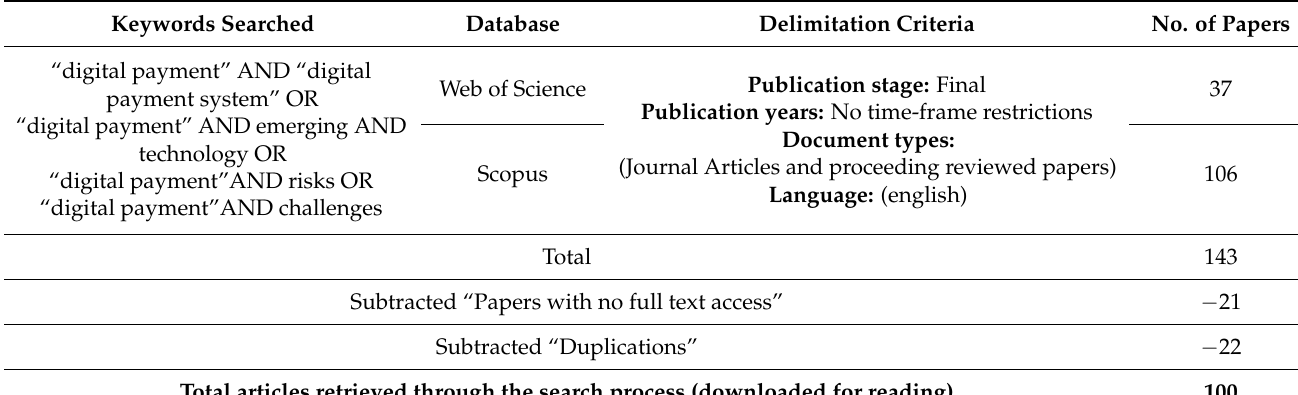
Table 3. The searching and selection